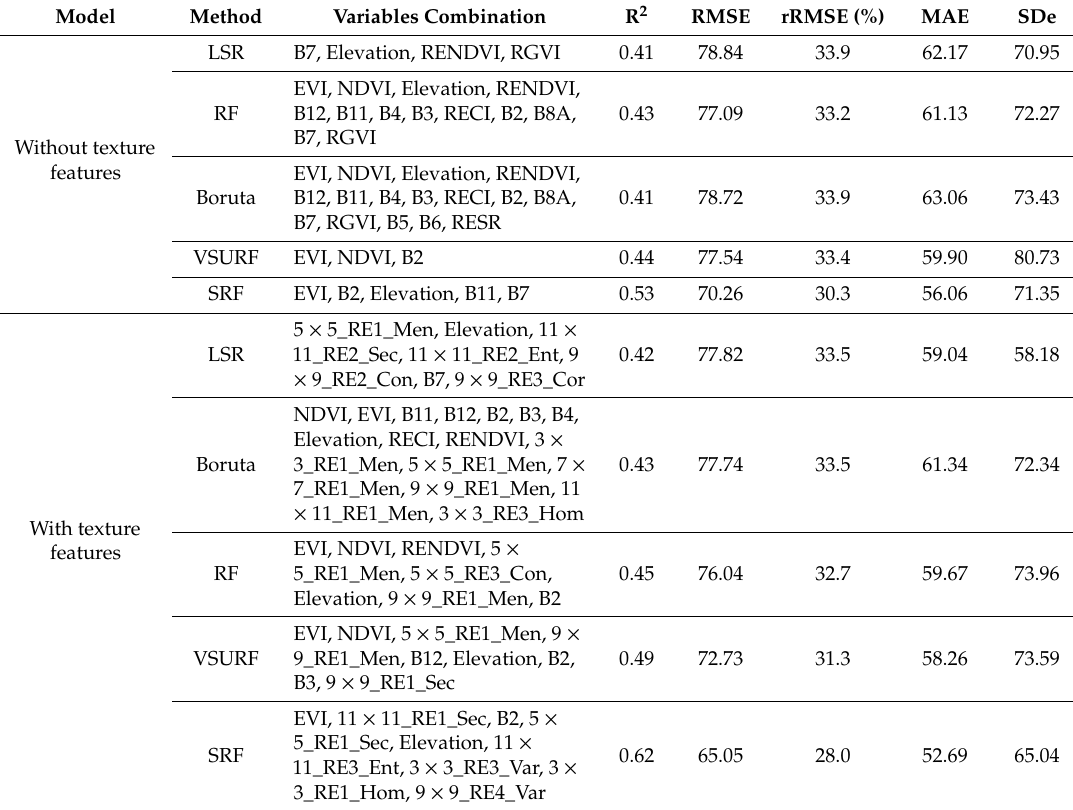
Table 7. Accuracy comparison of the GSV estimates (m 3 / ha) from the RFR models with various combinations selected by the LSR, RF, Boruta, VSURF, and SRF variable selection methods.